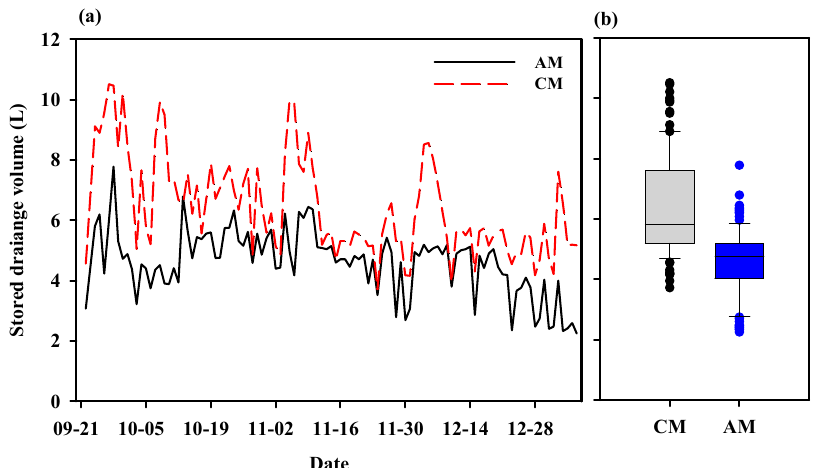
Figure 5. Changes in stored drainage volume in the drainage tank ( a ) and box-plot comparison between conventional (CM) and alternative (AM) nutrient-replenishment methods ( b ) during the experimental period.